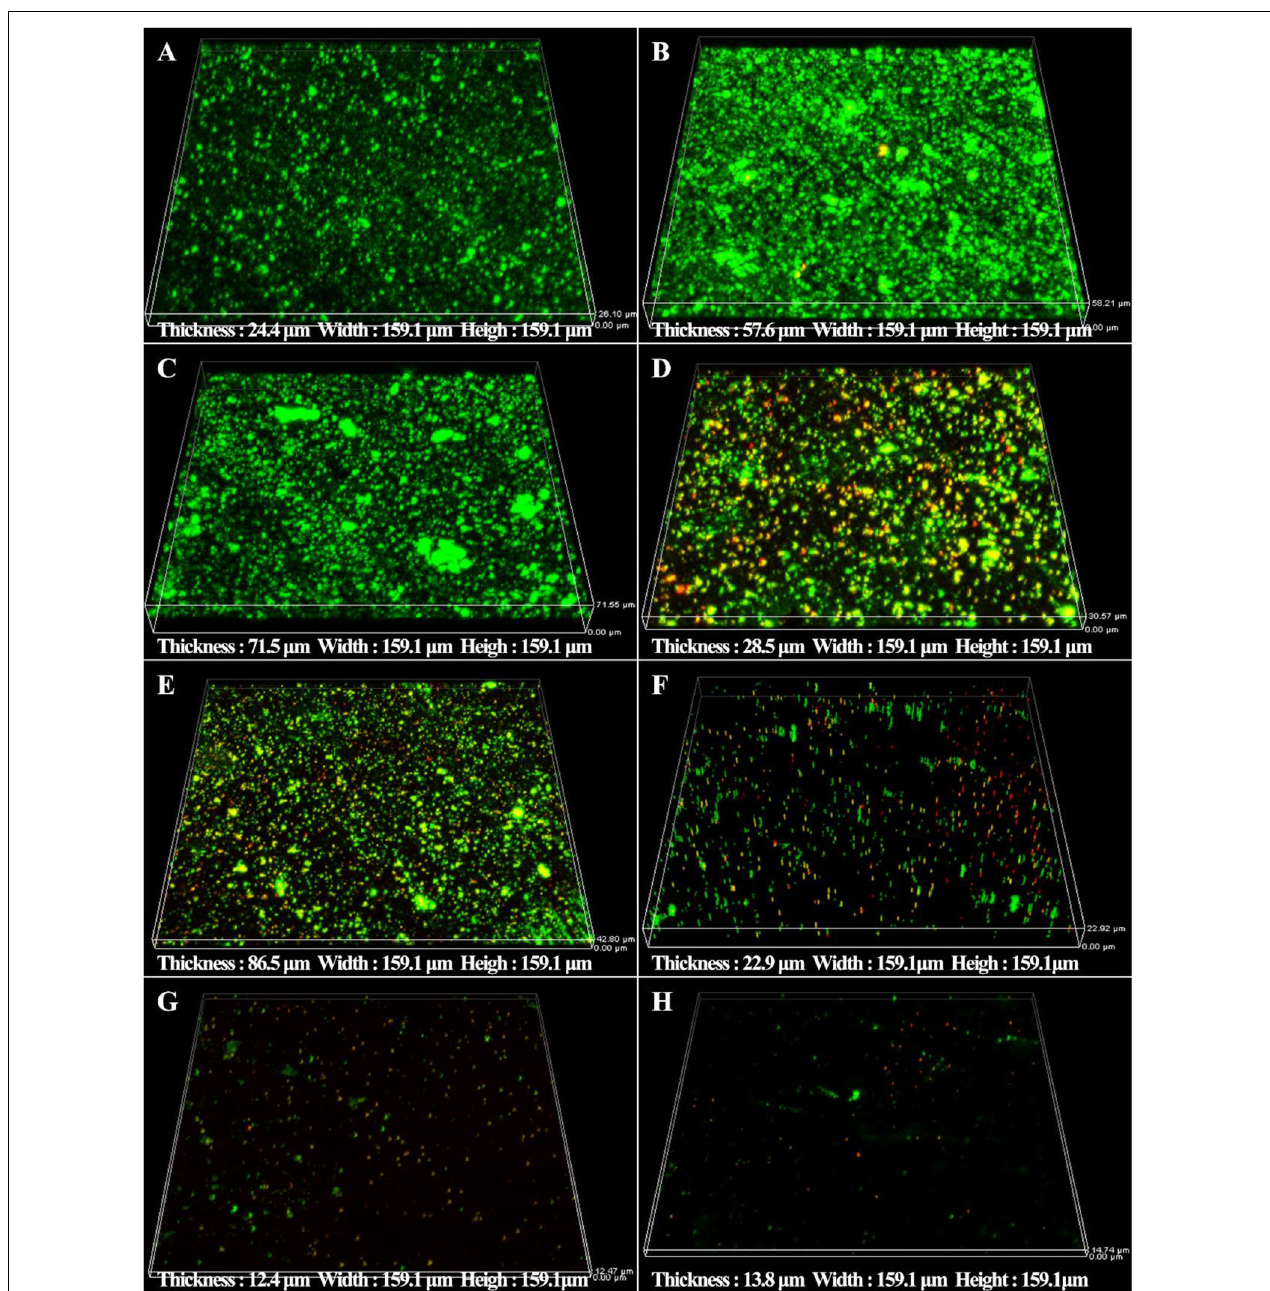
FIGURE 5 | CLSM images of sessile cells after 3-day biofilm prevention test: (A) no treatment (control), (B) 1 ppm D -Tyr, (C) 100 ppm D -Met, (D) 5 ppm CMIT/MIT, (E) 5 ppm CMIT/MIT + 1 ppm D -Tyr, (F) 5 ppm CMIT/MIT + 100 ppm D -Met, (G) 5 ppm CMIT/MIT + 1 ppm D -Tyr + 100 ppm D -Met, and (H) 25 ppm CMIT/MIT.